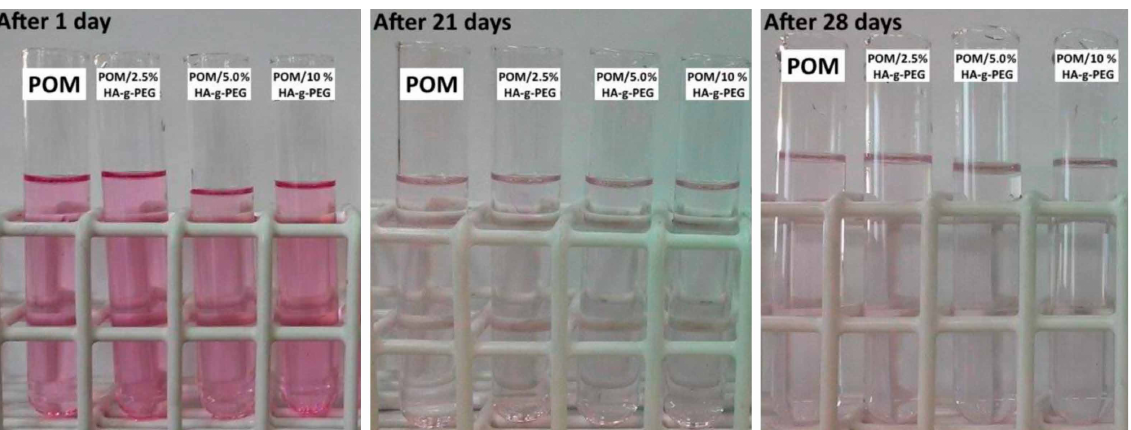
Figure 14: Colorimetric assay of formaldehyde release from POM/HA-g-PEG 600 composites after 1, 21, and 28